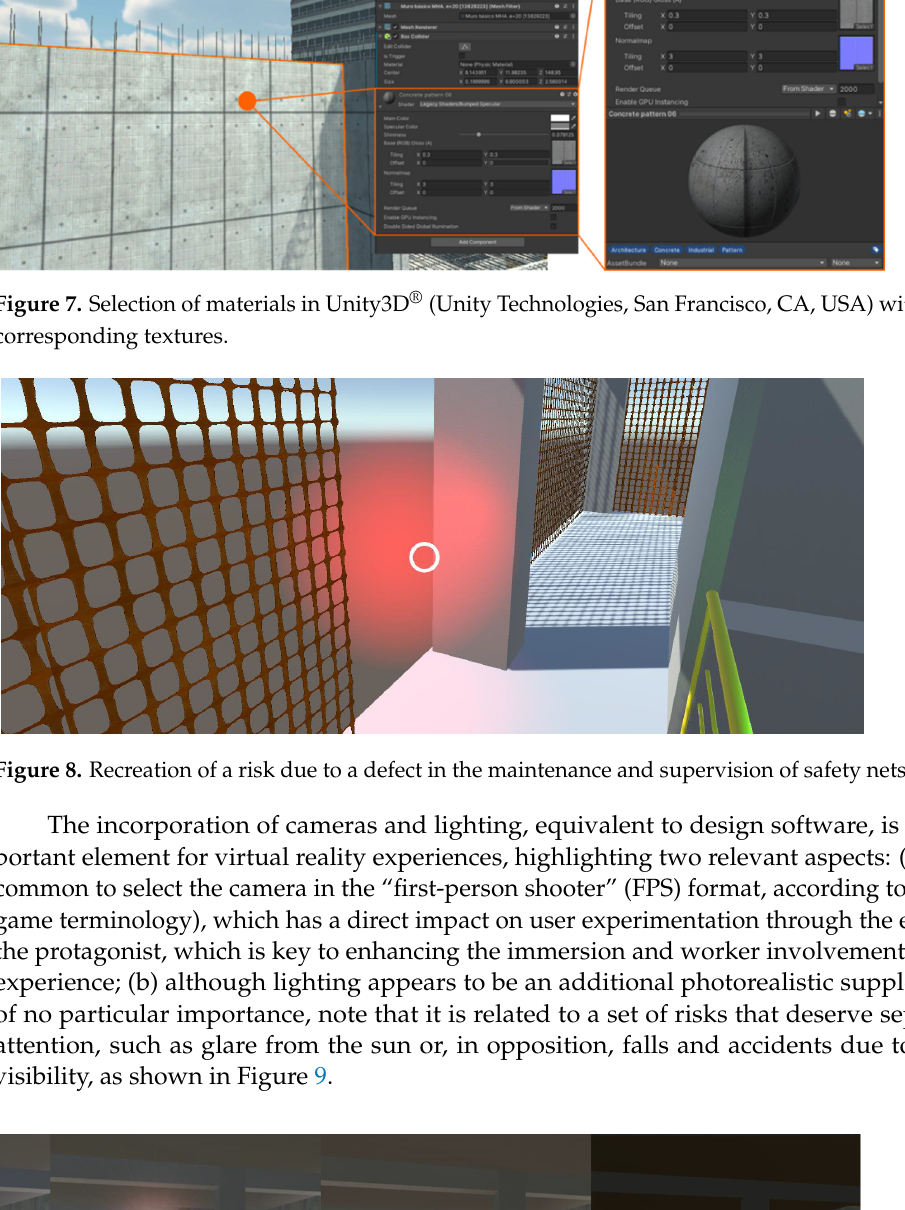
Figure 7. Selection of materials in Unity3D ® (Unity Technologies, San Francisco, CA, USA) with their corresponding textures.